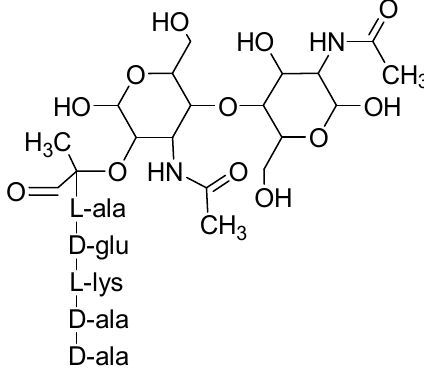
Figure 7. Disaccharide pentapeptide monomeric unit of peptidoglycan.